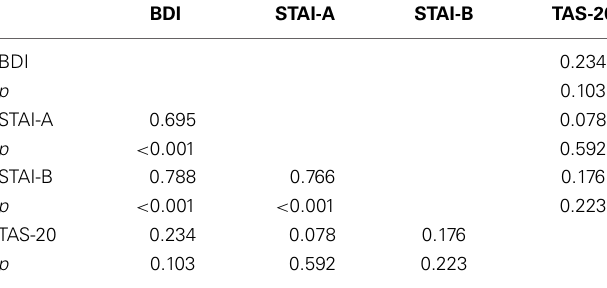
Table 2 | Correlations between the different covariates ( n = 50).